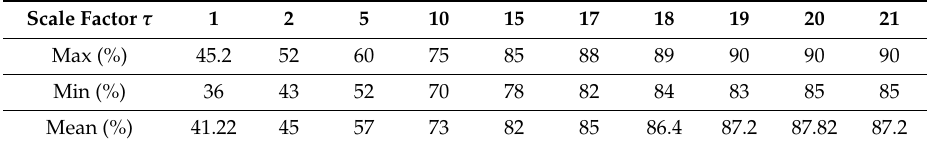
Figure 25. The mean classification accuracy and computation time using MLZC with different scale factor τ . Table 4. Detailed classification accuracy of the experimental data using di ff erent scale factor τ